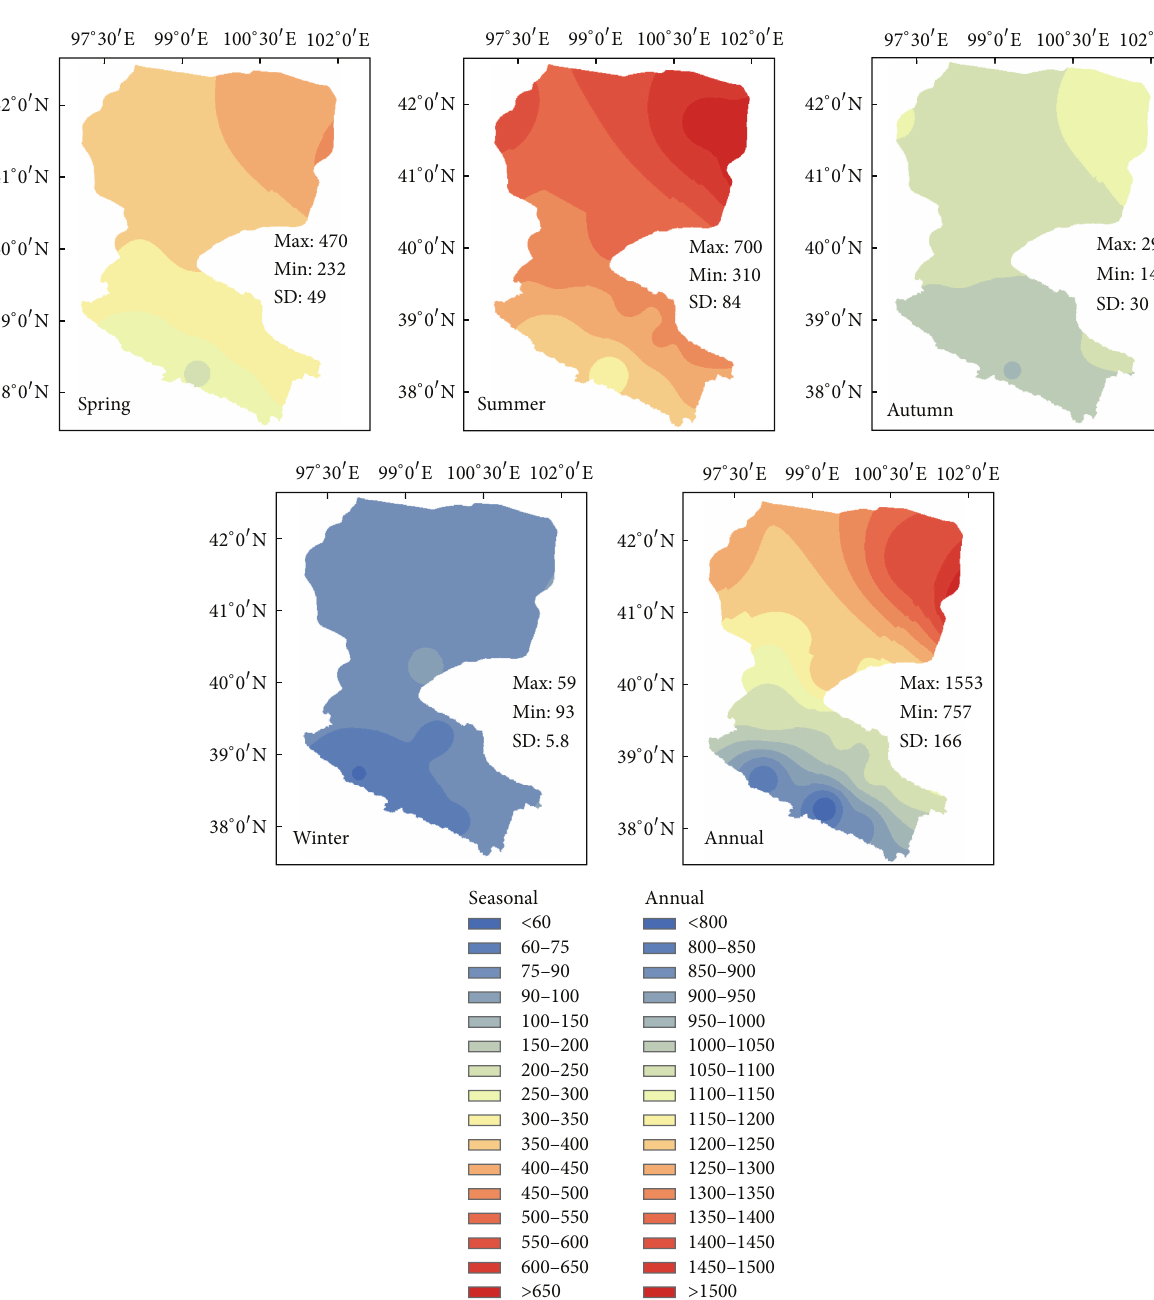
Figure 6: Spatial patterns of the seasonal and annual mean ET 0 in the whole HRB from 1961 to 2014. Max and Min denote the maximum and minimum values, respectively, of ET 0 over the whole basin. SD indicates the standard deviation of the spatial variations of ET 0